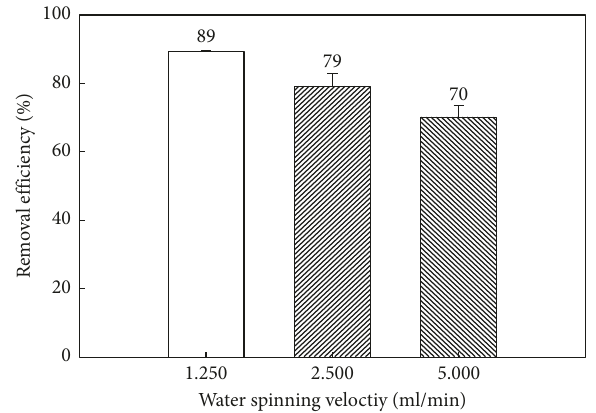
Figure 7: Arsenic removal efficiency of titanium hollow-fiber ad- sorbents obtained by another spinning velocity of inner coagulation (initial As concentration: 0.2mg/L; quantity of adsorbents: 0.1g).